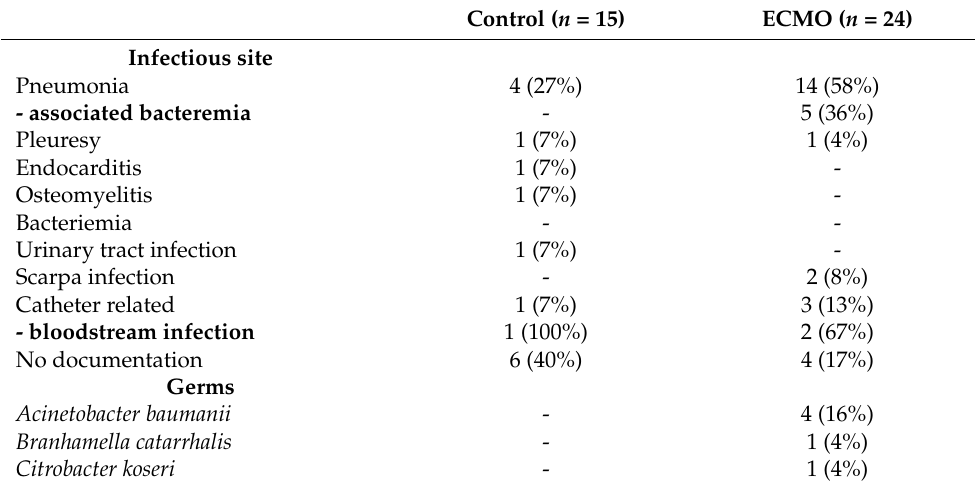
Table 2. Bacteriologic